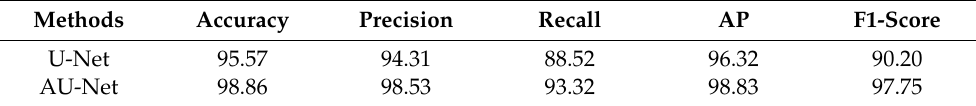
Figure 5. Schematic diagram of the U-Net adding a feature map output. Each dark green box corresponds to a multi-channel feature map. The number of channels is denoted on top of the box. The x-y-size is provided on the lower edge of the box. Light green boxes represent copied feature maps. The arrows denote the different operations. Table 5. Comparing the impact of the U-Net and AU-Net on the final benefit of the network. In order to rule out that our experimental data were obtained by random or accidental occurrence, we used SPSS to conduct a one-way analysis of variance on the experimental data. Our null hypothesis ( H 0 ) was that performance metrics were equal, and any small gains or losses observed were not statistically significant. H 1 was the alternative hypothesis. We set α = 0.05. The analysis results show that F = 5.764 > F crit = 5.318, P = 0.043 < α = 0.05, reject H 0 . We performed the same analysis on the data in Tables 6 and 7; please refer to the following for